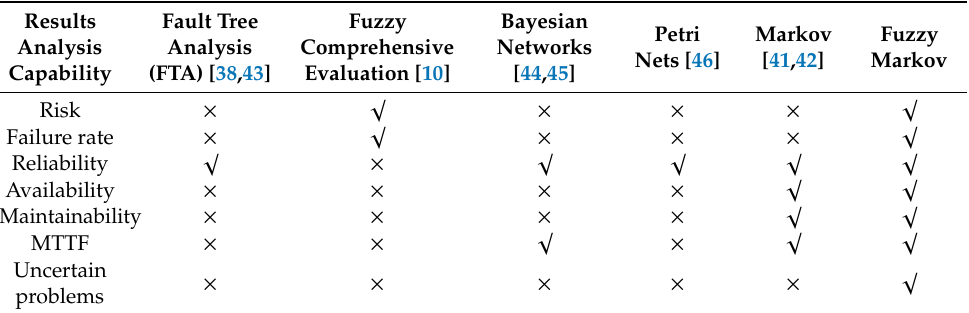
Table 6. Method comparison.